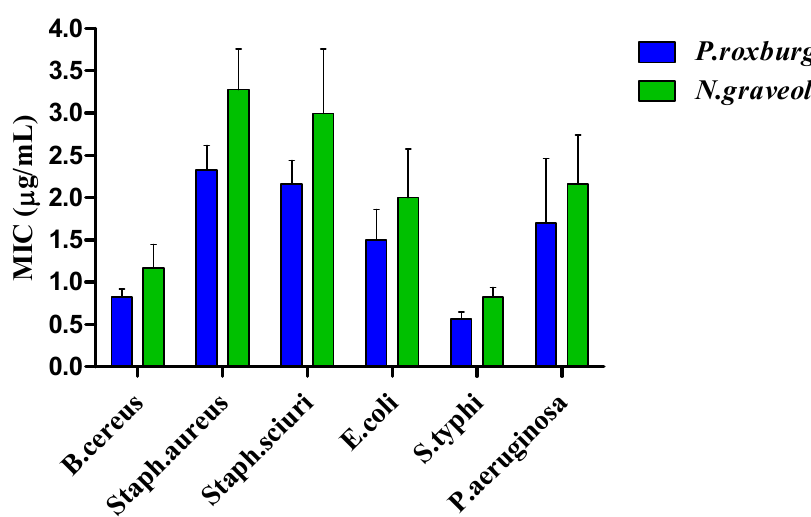
Figure 5. Minimum inhibitory concentrations of P. roxburghii and N. graveolens extracts against foodborne pathogenic bacteria.